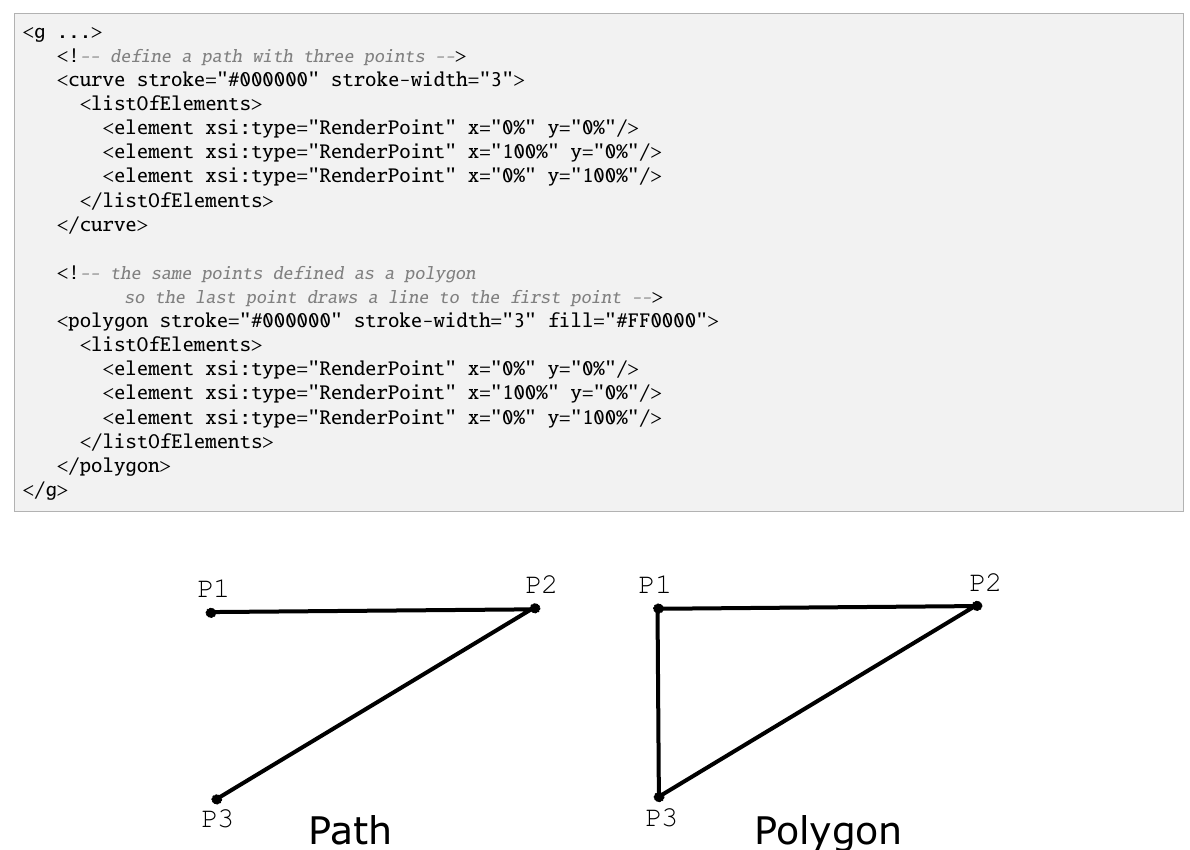
Figure 13: Rendering of a Path vs. rendering of a Polygon with the same base